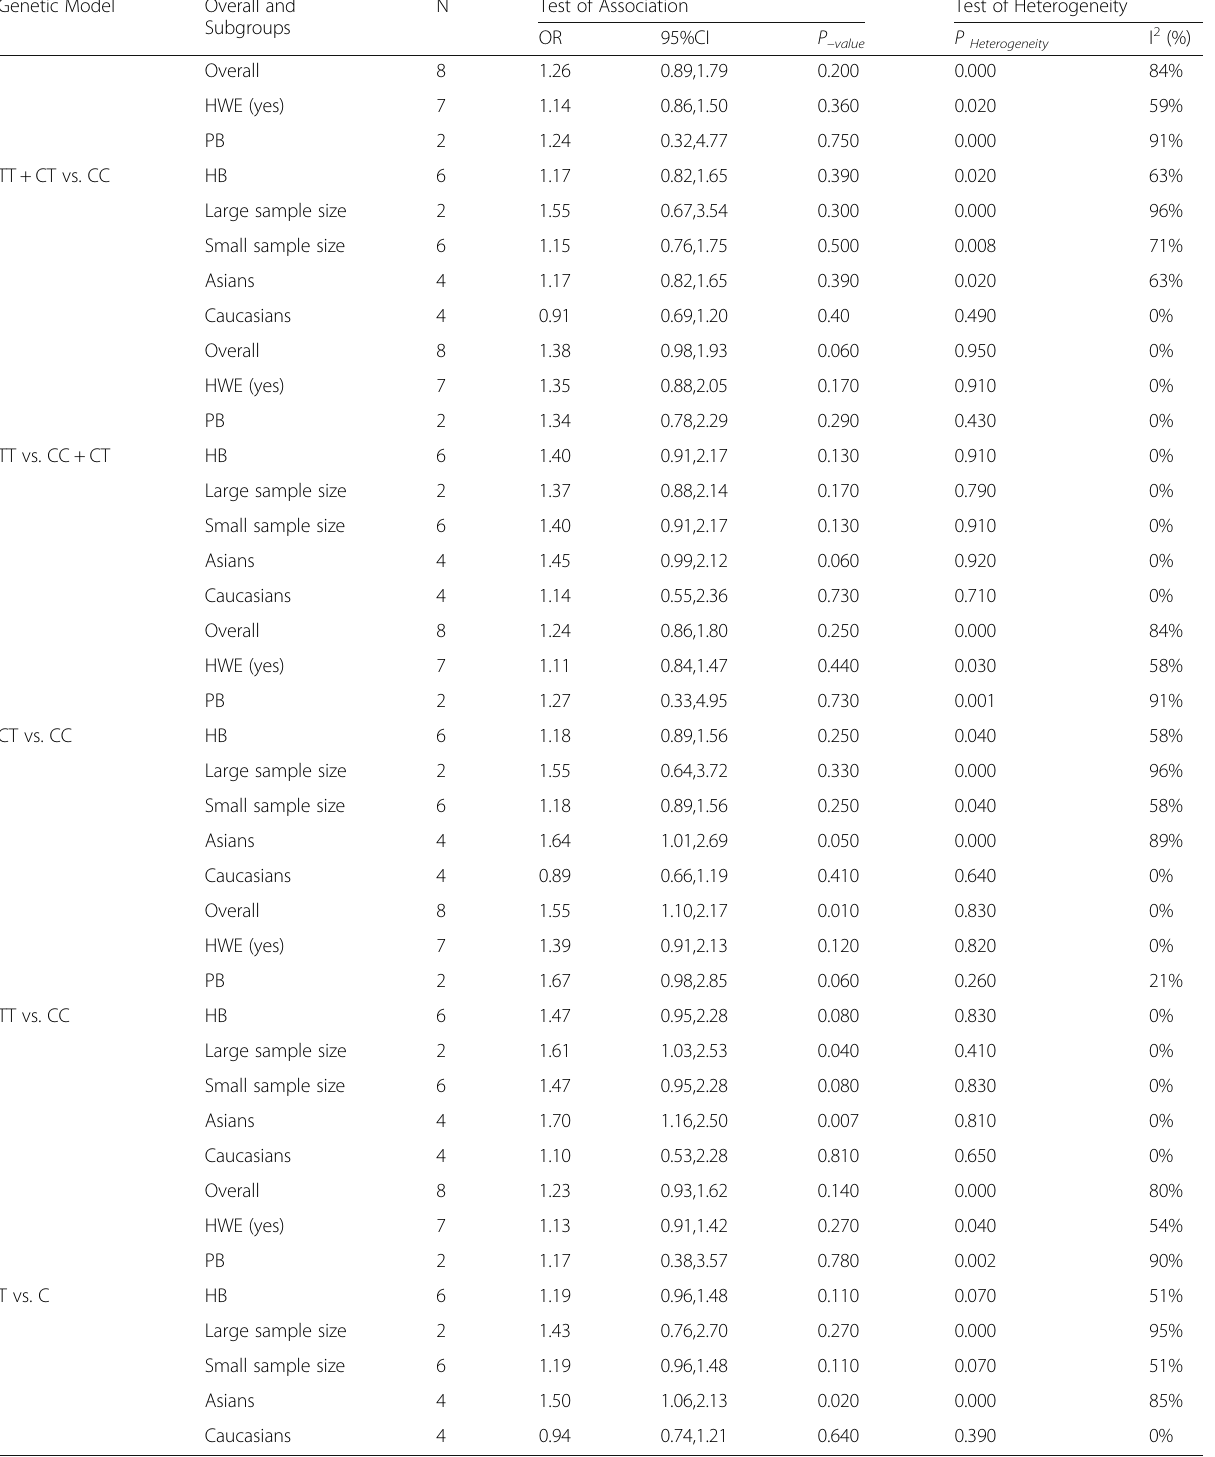
Table 4 Summary of odds ratios (95% CI) in the analysis of the relationship between VEGF gene polymorphisms in rs3025039 and coronary artery disease susceptibility Genetic